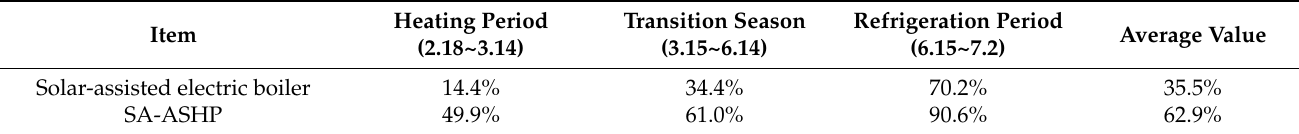
Table 3. Solar fraction of the two solar water heating systems.